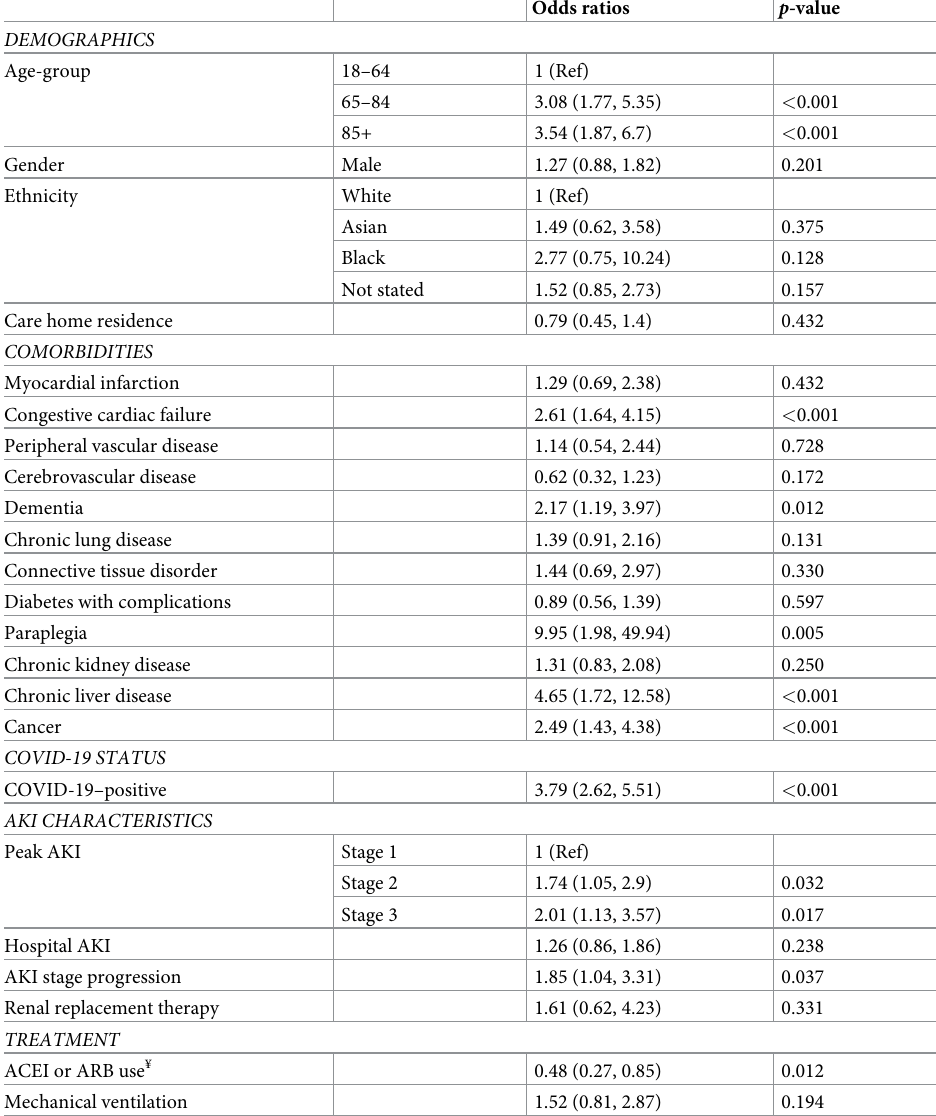
Table 4. Multivariable logistic regression to identify risk factors for mortality in patients with AKI.